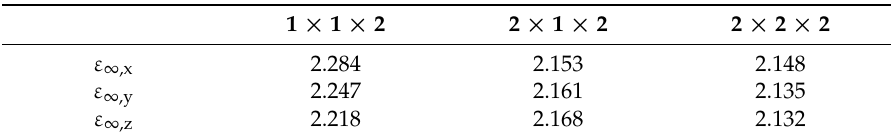
Table 7. Calculated high-frequency dielectric constants ( ε ∞ ) for the B3LYP-optimized 1 × 1 × 2, 2 × 1 × 2, and 2 × 2 × 2 Mg 2 SiO 4 bulk structures along the x , y , and z